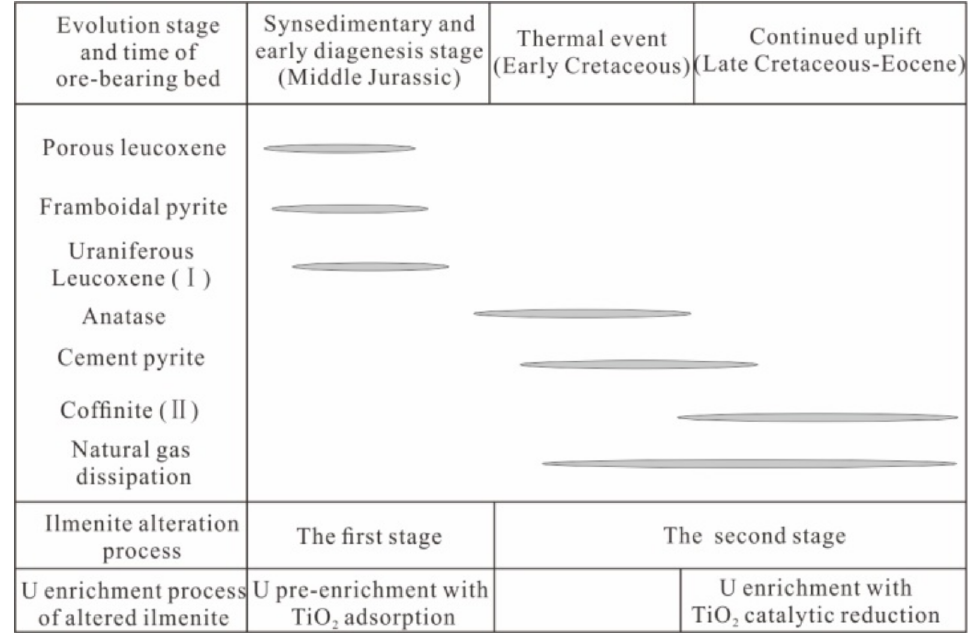
Figure 6. Formation time series of ilmenite alteration products and U